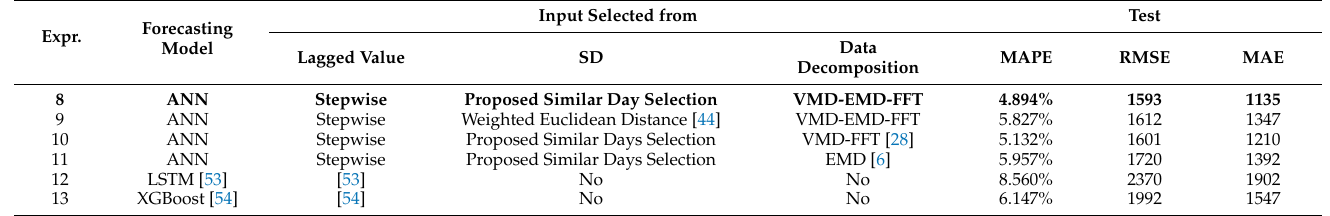
Table 14. Performance comparison between the proposed model and the previous studies applied with testing